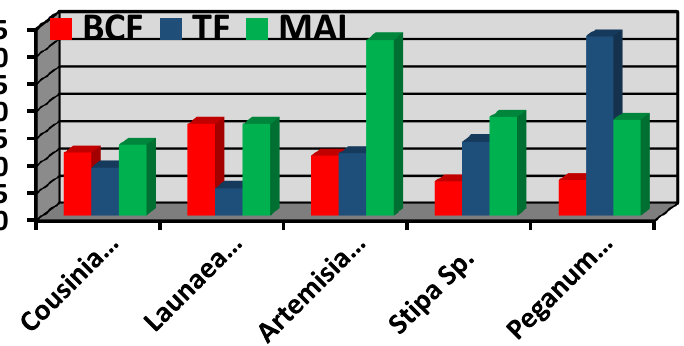
Figure 5. A diagram comparing the BCF, TF, and MAI values for samples of native plants based on the average of all the elements.